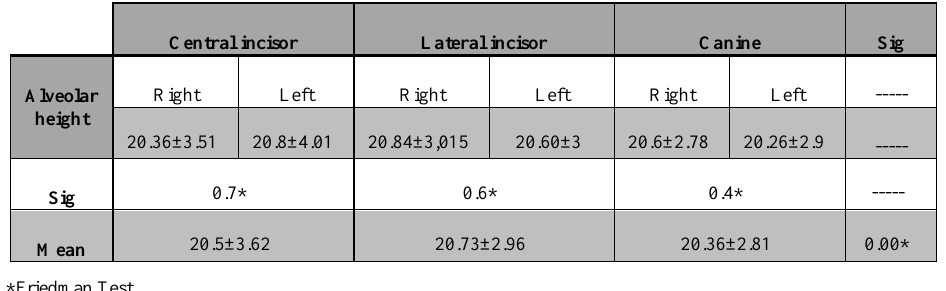
Table 1. Alveolar height (mm).